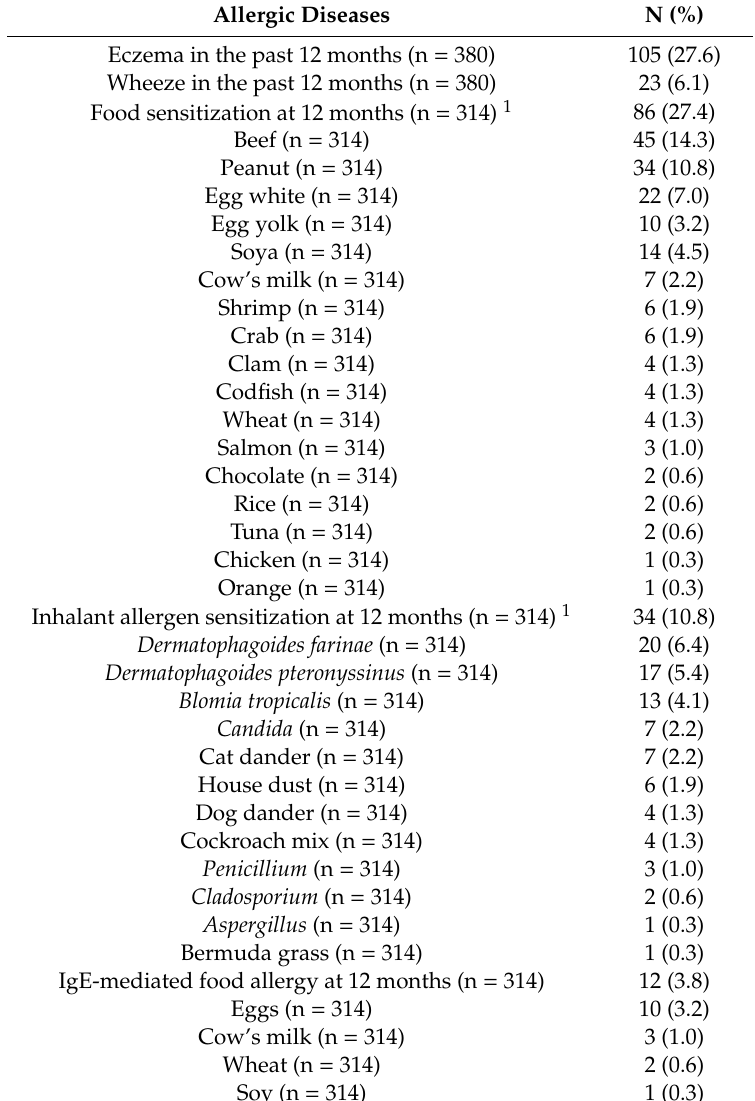
Table 2. Allergic diseases in infants during the first year of